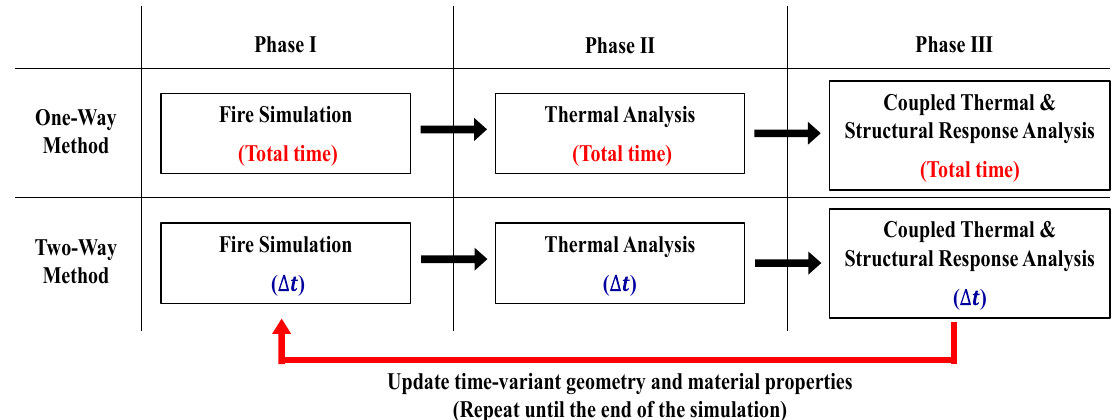
Figure 3. Differences between the schemes of the one-way and two-way fluid-structure interaction methods for determining the non-linear structural response to fire. ∆𝑡 : time increment.